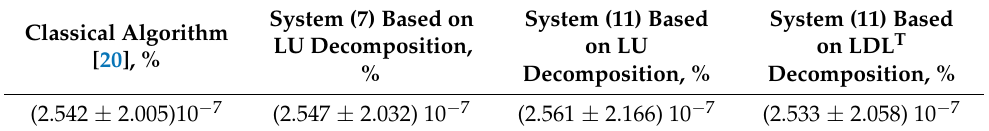
Figure 3. Normalized root mean square error of the parameters [45]. Table 3 shows the mean values of the normalized root mean square error of the pa- rameter estimation and their standard deviations.